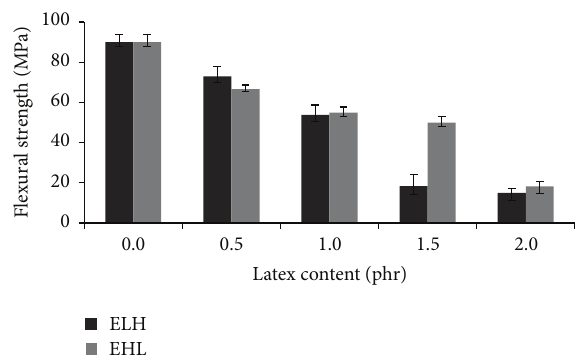
Figure 3: The flexural strength of porous epoxy extracted by toluene using mixing sequence of EHL and ELH, respectively.